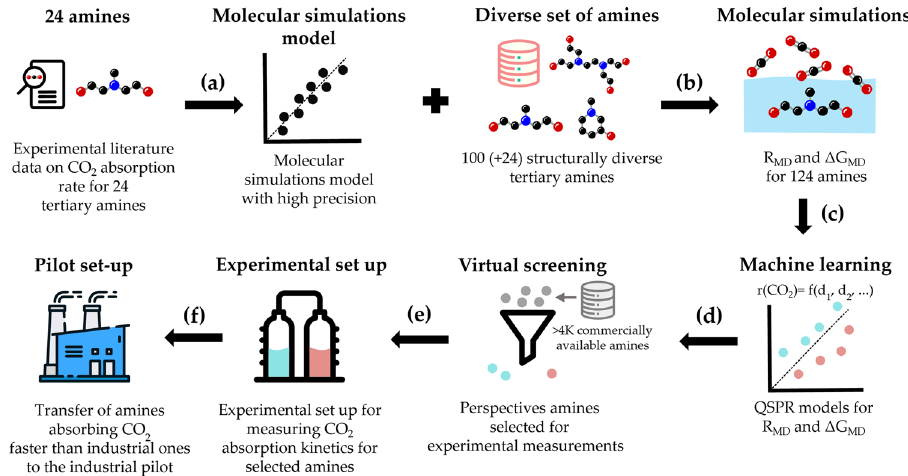
Fig. 1 Work fl ow of the methodology suggested in this paper. a A high precision molecular simulation-based model for absorption rate prediction is developed 19 and validated with experimental data on CO 2 absorption rates for 24 tertiary amines 20 . The accuracy of the Gibbs free energies of absorption is better than 1 kJ mol − 1 in comparison to experimental values 19 . b This model is applied to a diverse dataset containing 100 tertiary amine structures to calculate the CO 2 absorption rate (R MD ) and free energy of absorption ( Δ G MD ) (see “ Methods ” ). c QSPR models were built for R MD and Δ G MD . d QSPR models were used to select perspective commercially available amines from public datasets. e Experimental measurement of CO 2 absorption rates for selected amines. f The most selective ones can be further studied and eventually tested in a pilot unit.